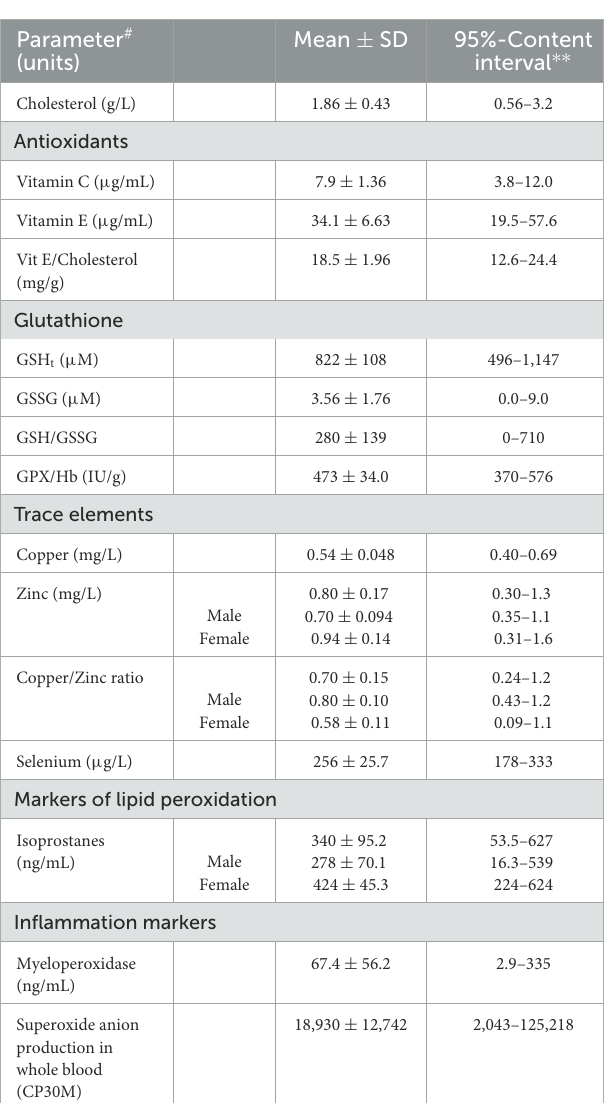
TABLE 2 Distribution characteristics and provisional 95%-content interindividual physiological intervals of oxidative stress parameters in presumably healthy Beagle dogs ( N = 14) ∗